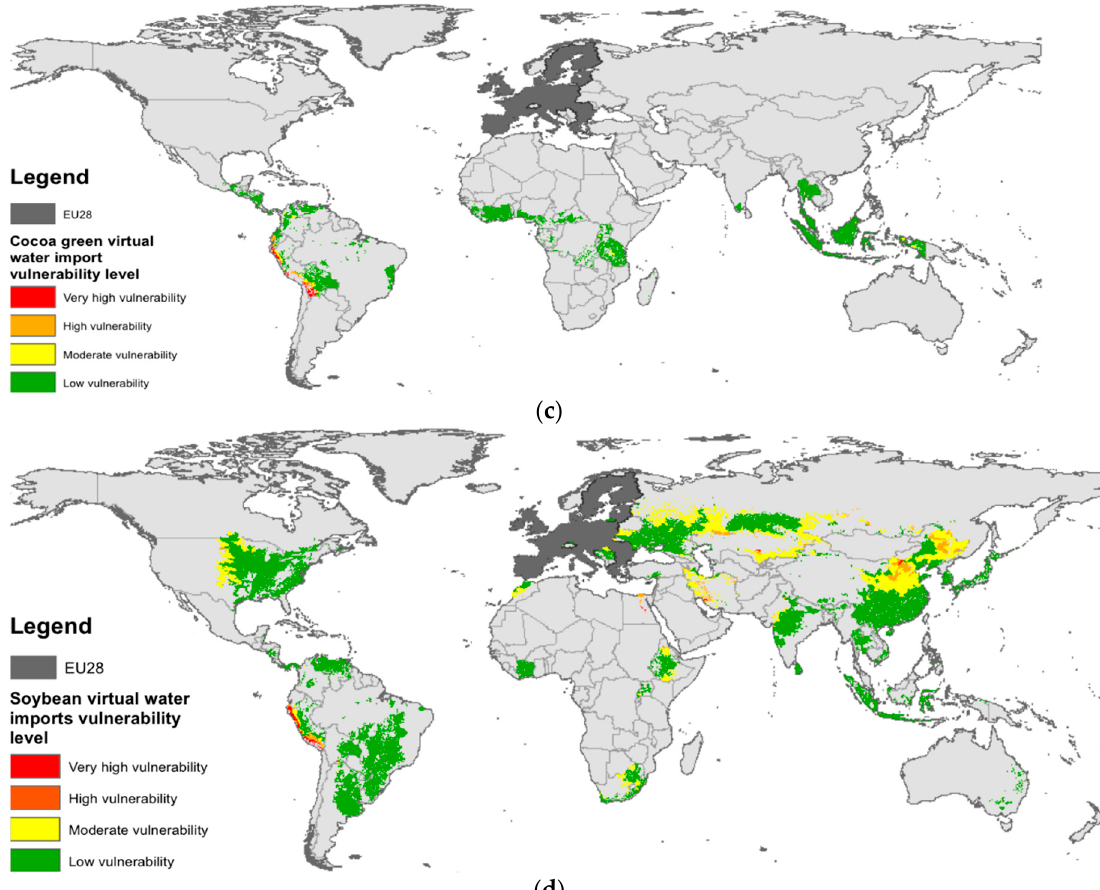
Figure 8. Vulnerability level for green virtual water imports to the EU related to coffee ( a ), oil palm ( b ), cocoa ( c ) and soybean ( d ).